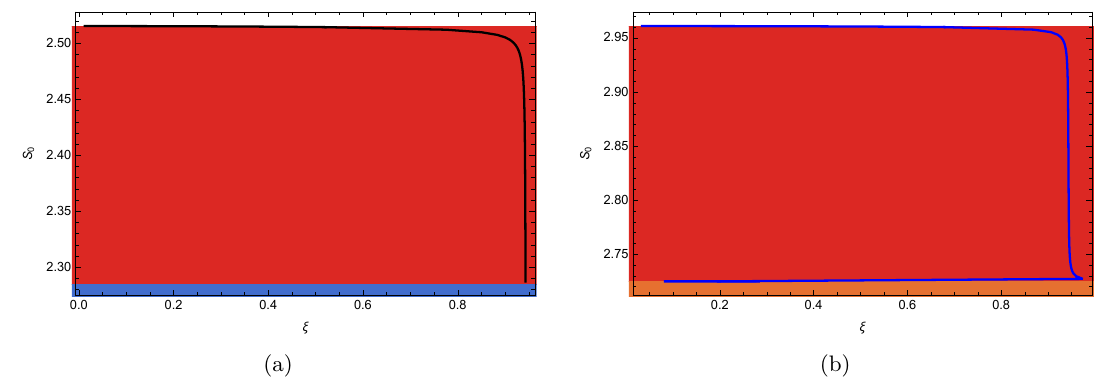
Figure 32 . The ratio of the relevant couplings for two fixed values ϕ 0 = 3 . 25 , 4 as we change the value of S 0